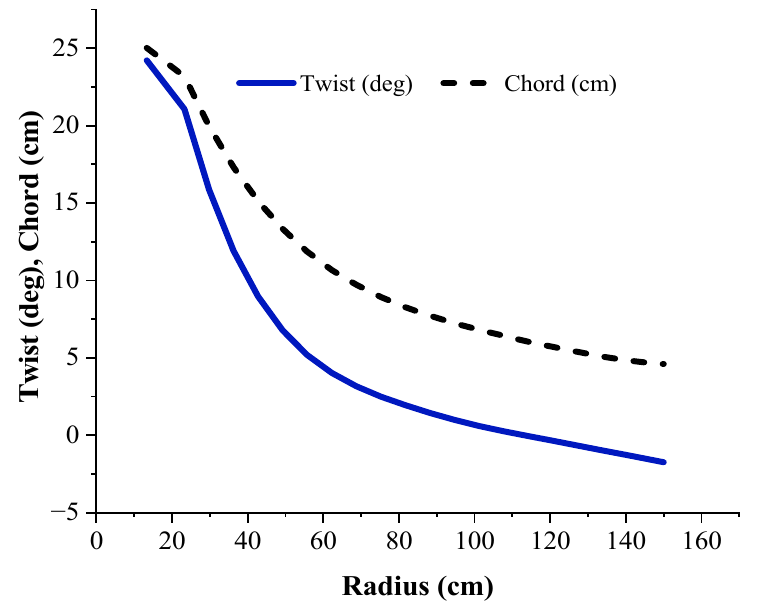
Figure 2. The geometry of the base turbine [33].